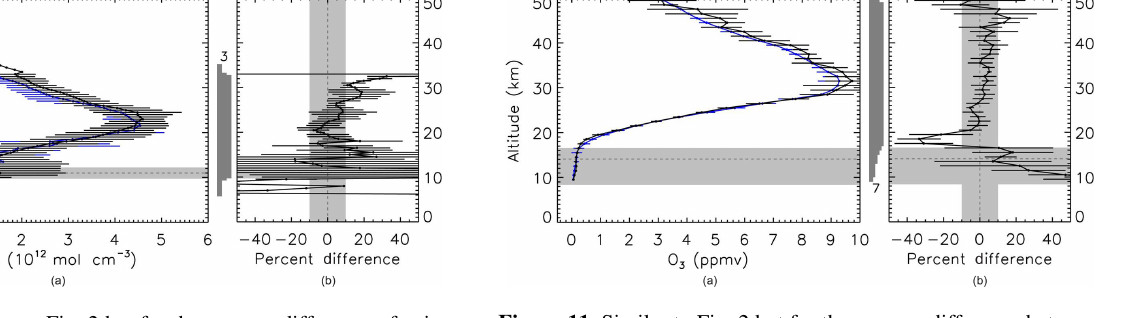
Figure 10. Similar to Fig. 2 but for the average difference of coin- cident pairs for SAGE III-ISS lunar occultation measurements and Lauder ozonesonde profiles obtained from June 2017 to May 2018.